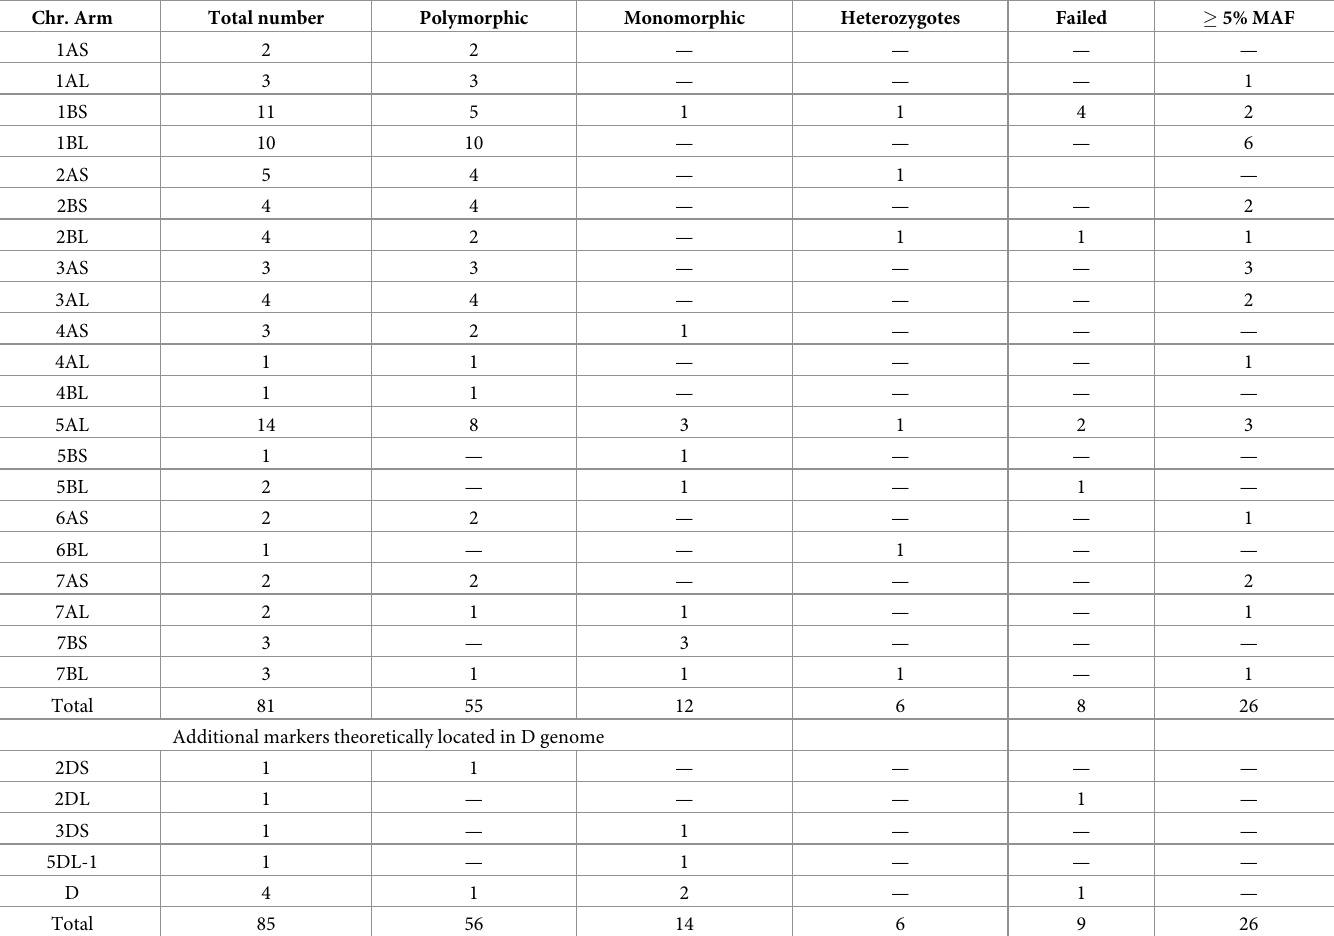
Table 4. Number of KASP markers amplified in the durum wheat collection and their chromosomal position. Chr.